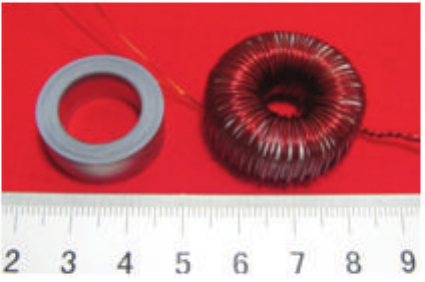
Figure 2: Wounded toroidal cores by Fe-6.5wt.%Si ribbons, before (left) and after (right) wounding copper wires for magnetic testing.